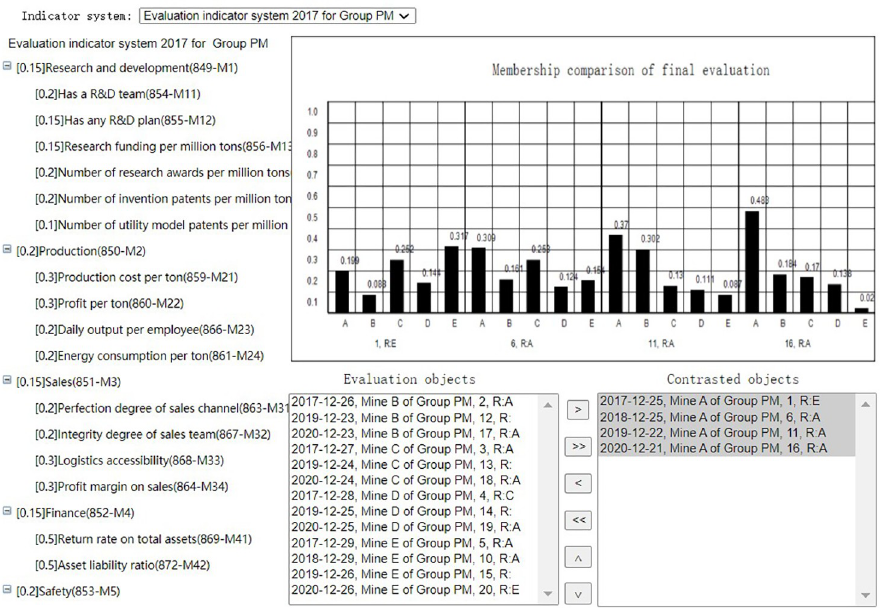
Fig 22. Longitudinal membership